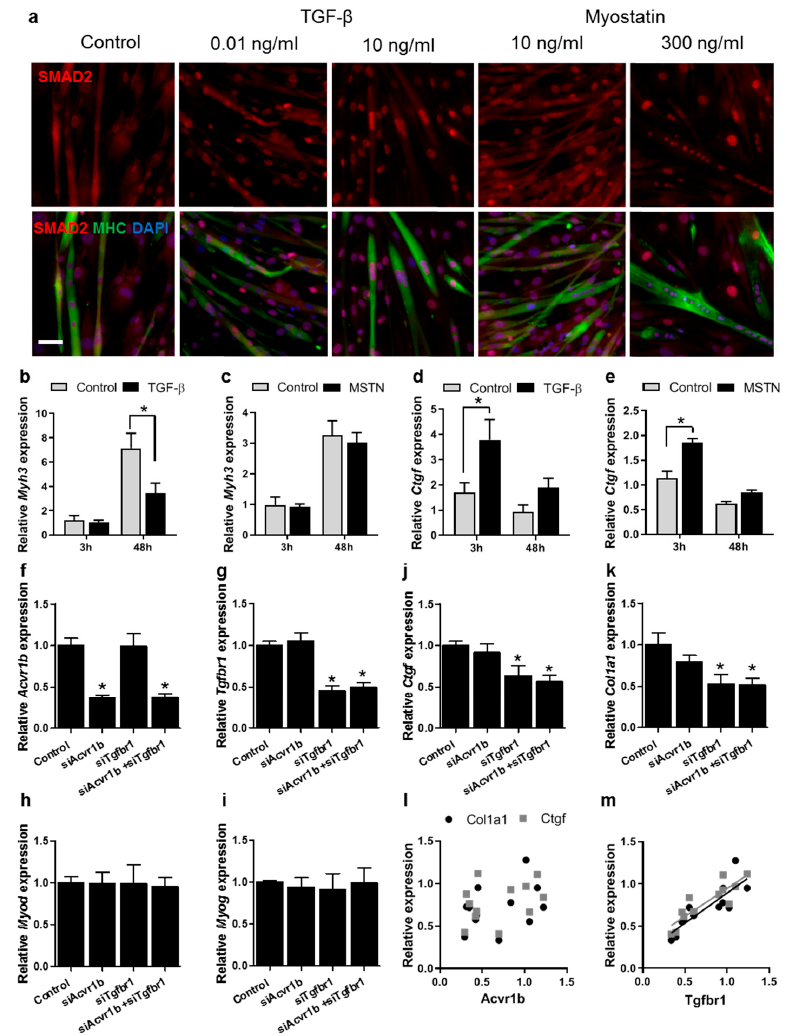
Figure 5. TGF- β has a larger effect on myoblasts compared to myostatin. a Primary cells were induced to differentiate for 2 days and subsequently treated with TGF- β (0.01 or 10 ng/mL) or myostatin (10 or 300 ng/mL). Myotubes were stained for MHC (green) and nuclei were stained using DAPI (blue). SMAD2 is visible in red. The scale indicates 100 µm. After TGF- β or myostatin treatment, SMAD2 was translocated to the nucleus in both myotubes and undifferentiated myoblasts compared to controls. b, c In primary mouse myoblasts, expression levels of Myh3 mRNA were reduced after 48 h TGF- β treatment compared to those in untreated cells ( b ), while no differences were observed for myostatin (MSTN) ( c ). d, e Expression levels of Ctgf were increased after 3 h TGF- β ( d ) or myostatin treatment ( e ) compared to those in untreated cells, although TGF- β had a larger effect. f, g Treatment with specific siRNAs reduced levels of Acvr1b ( f ) or Tgfbr1 ( g ). h, i Knockdown of Acvr1b or Tgfbr1 did not affect Myod ( h ) or Myog ( i ) expression levels. j, k Tgfbr1 knockdown slightly reduced Ctgf ( j ) and Col1a1 ( k ) expression levels, while Acvr1b knockdown had little effect. The combined knockdown of Tgfbr1 and Acvr1b did significantly reduce Ctgf and Col1a1 expression levels. Gapdh served as housekeeping gene; error bars indicate standard error of the mean; * indicates significant difference at p < 0,05; n = 3 experiments per condition; data were normalized to values of control cells at 0h. l, m There is a significant correlation between Tgfbr1 expression level and Ctgf and Col1a1 expression levels ( l ), while no such correlations were found between Acvr1b expression levels and Ctgf or Col1a1 expression levels ( m ).